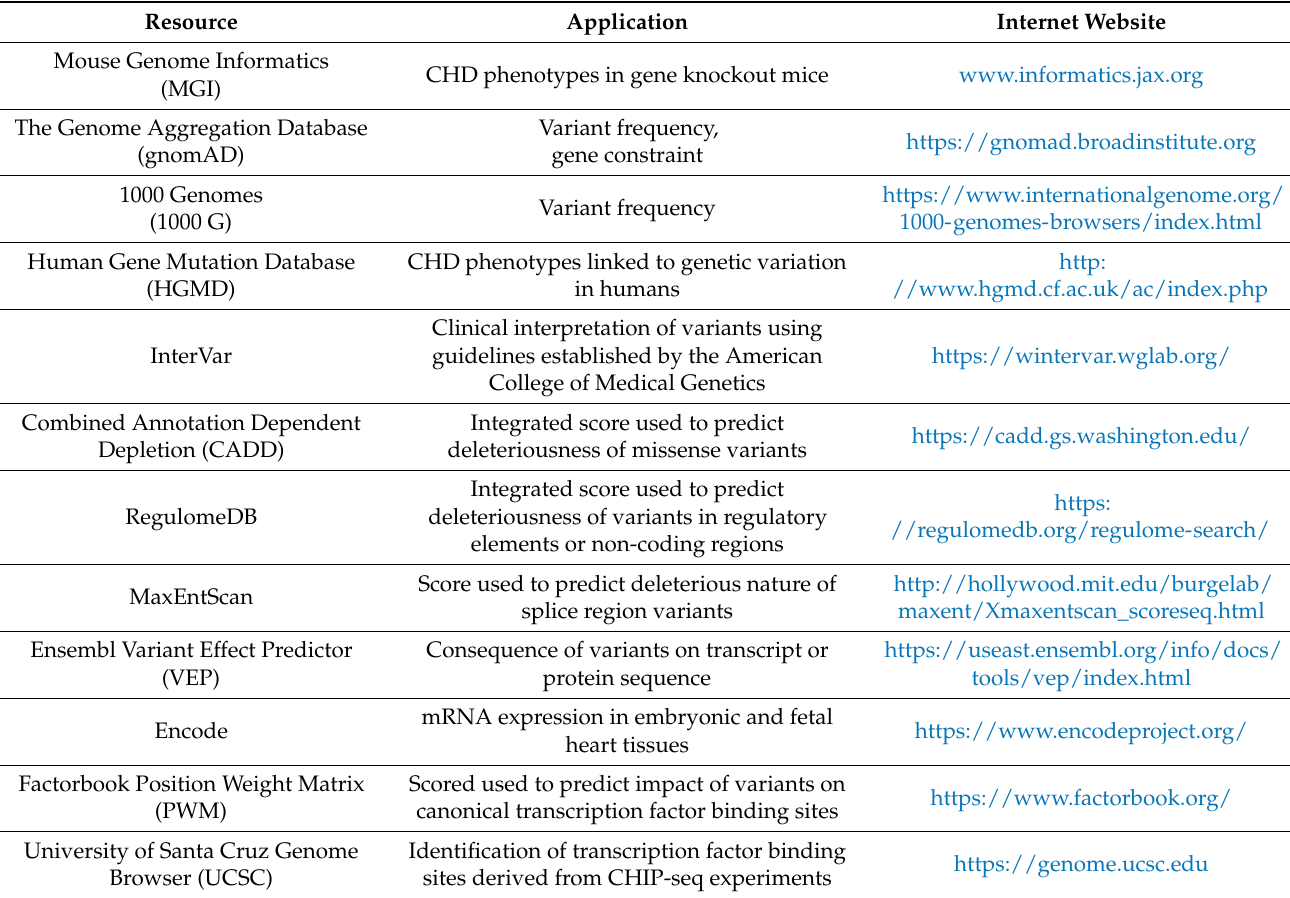
Table 1. Bioinformatics databases and tools.